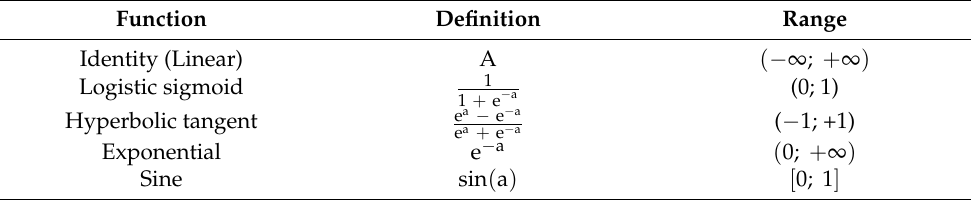
Table 2. Activation function of hidden and output layer of Multilayer perceptron (MLP)